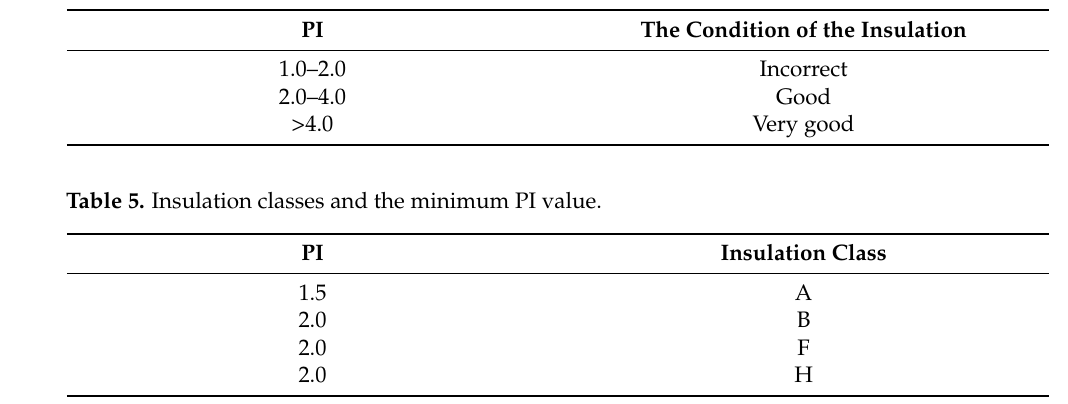
Table 4. Dependence of the polarization index on the condition of the insulation system.